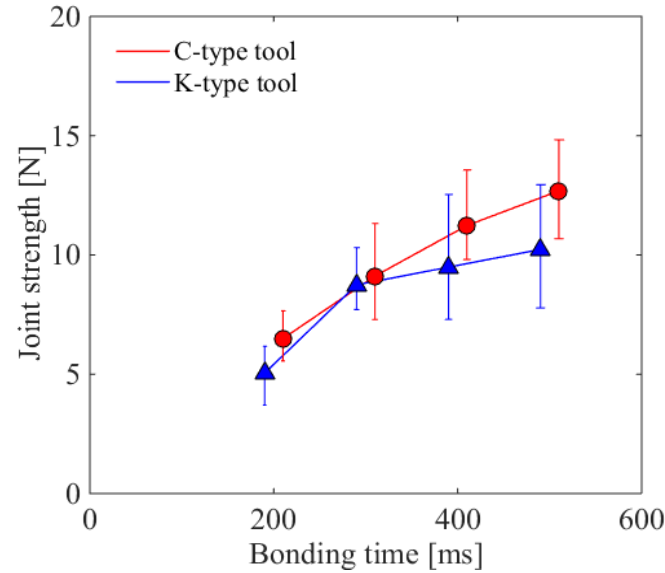
Figure 6. Joint strength of multi-layered Cu foil and Ni-plated Cu sheet.